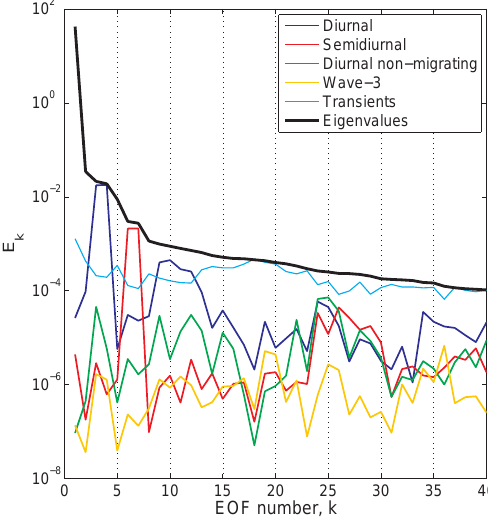
Fig. 3. Distribution of energy between thermal tides and transient waves as obtained from the analysis of the full-interval